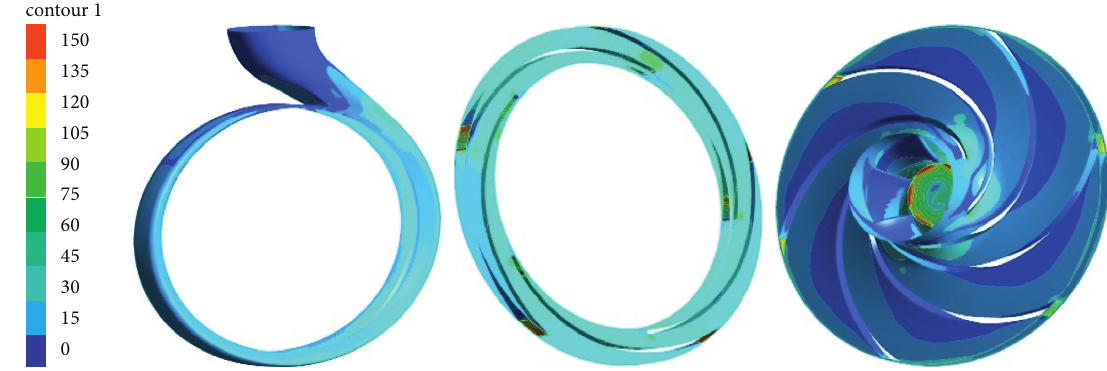
Figure 2: y + at the wall in PAT. Table 2: Pressure drop coefficients of three groups of grids at different flow rates.